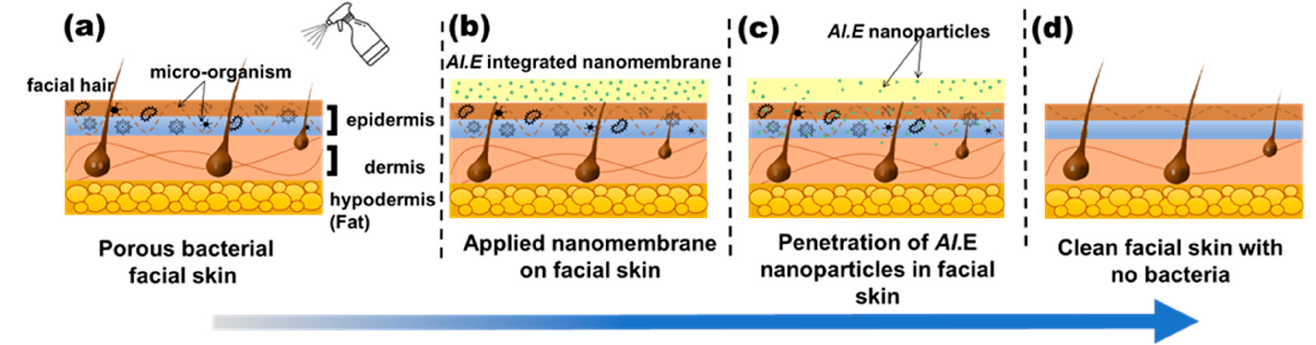
Figure 10. Working principle of the developed nanofiber facemask on facial skin. ( a ) wetting of facial skin with water ( b ) nanofiber membrane applied to the skin ( c ) penetration of AI nanoparticles in to skin pores ( d ) clean and bacteria free skin after removing the nanofiber membrane